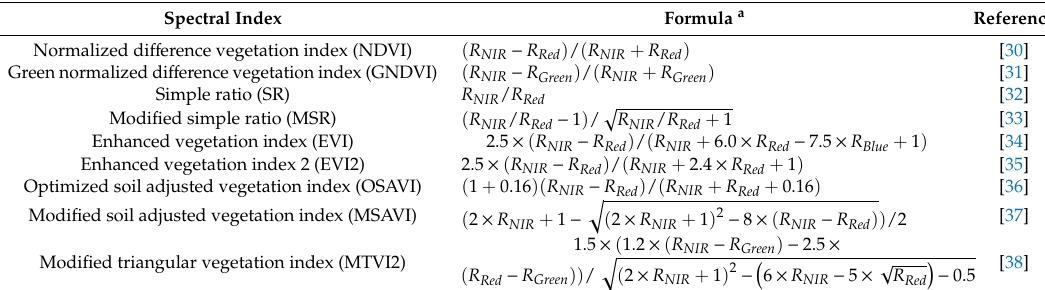
Table 3. Spectral indices used in this study.